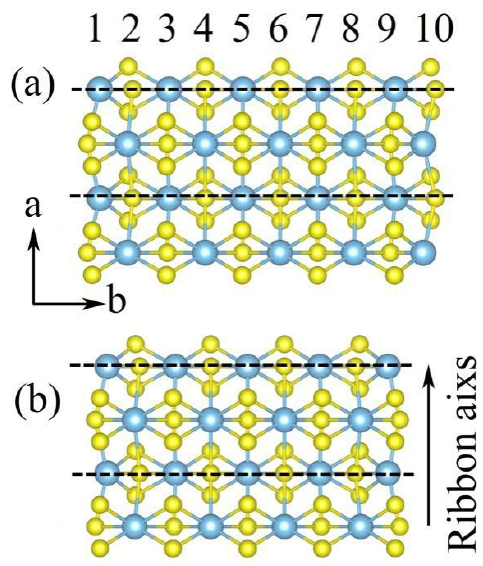
Figure 1. ( a ) The crystal structure of 10- a -TiS 3 nanoribbon (NR), and; ( b ) the crystal structure of 9- a -TiS 3 . Two dashed lines indicate the unit cell of nanoribbon along the a lattice vector. The dashed lines indicate the TiS 3 chain in monolayer TiS 3 .